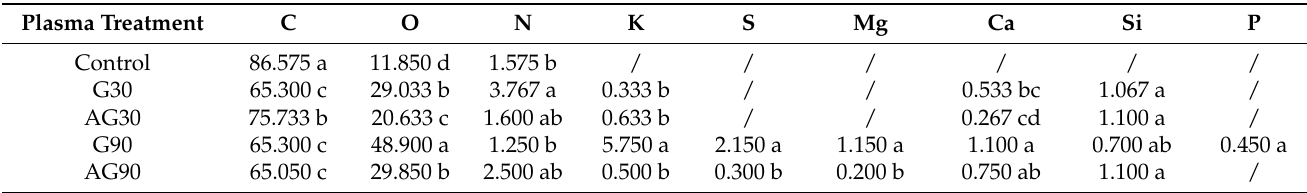
Table 1. Atomic share of the elements of control (untreated), vacuum control, and CP-treated seeds obtained from XPS. Seeds were treated in the glow regime for 30 (G30) or 90 s (G90) and in the afterglow regime for 30 (AG30) or 90 s (AG90). Displayed values are the means of three replications. Different letters (a–d) indicate statistically significant differences among treatments according to Duncan’s test ( p <